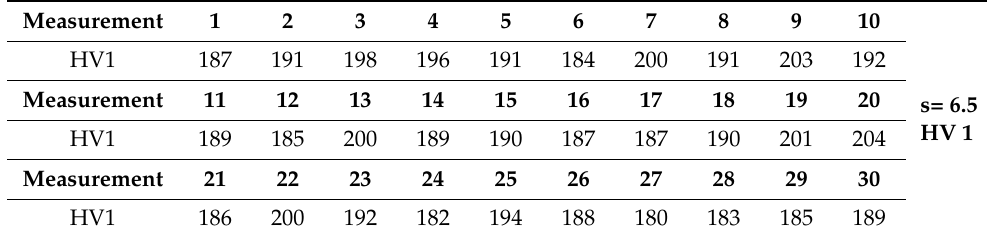
Table 3. Determination of statistical measurement uncertainty by standard deviation according to Formula